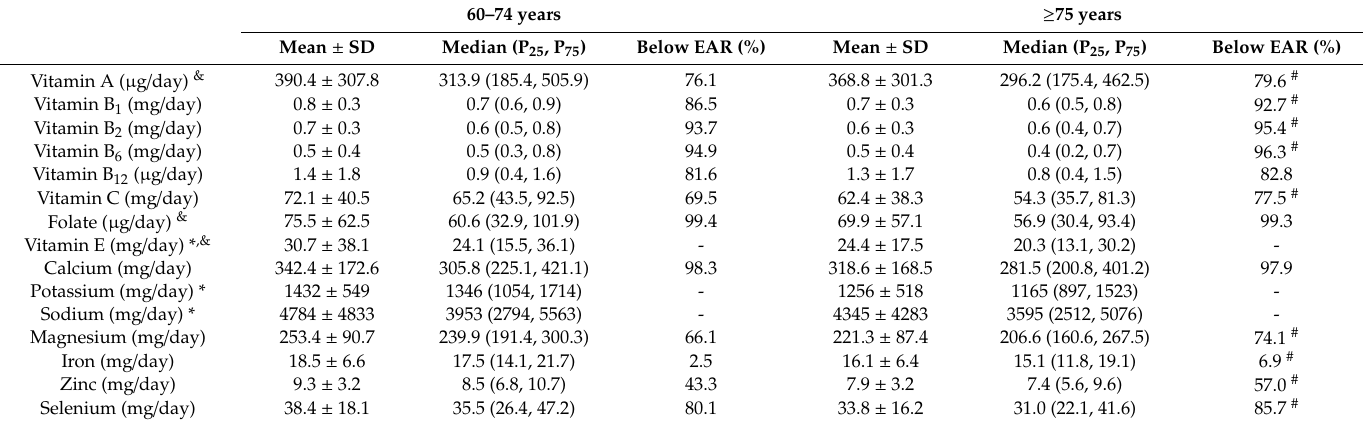
Table 3. Usual dietary intake and the prevalence of inadequate micronutrients in the elderly between di ff erent age groups.